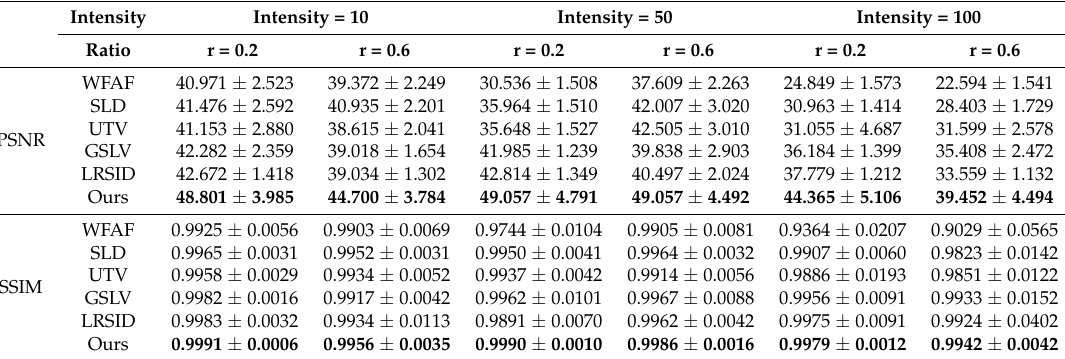
Table 3. The mean value of PSNR and SSIM of 32 images with nonperiodic